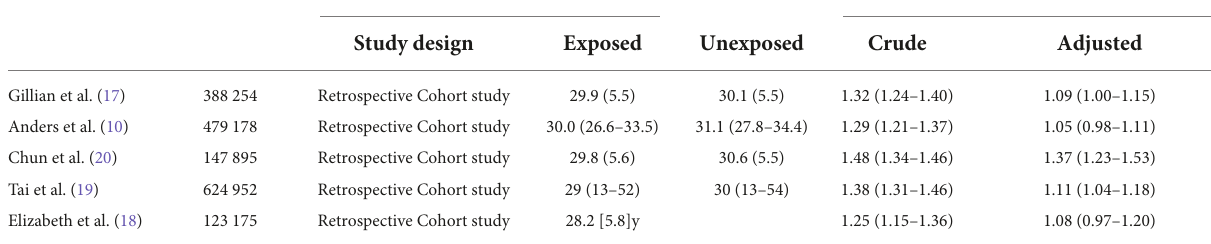
TABLE 1 Basic characteristics of the included